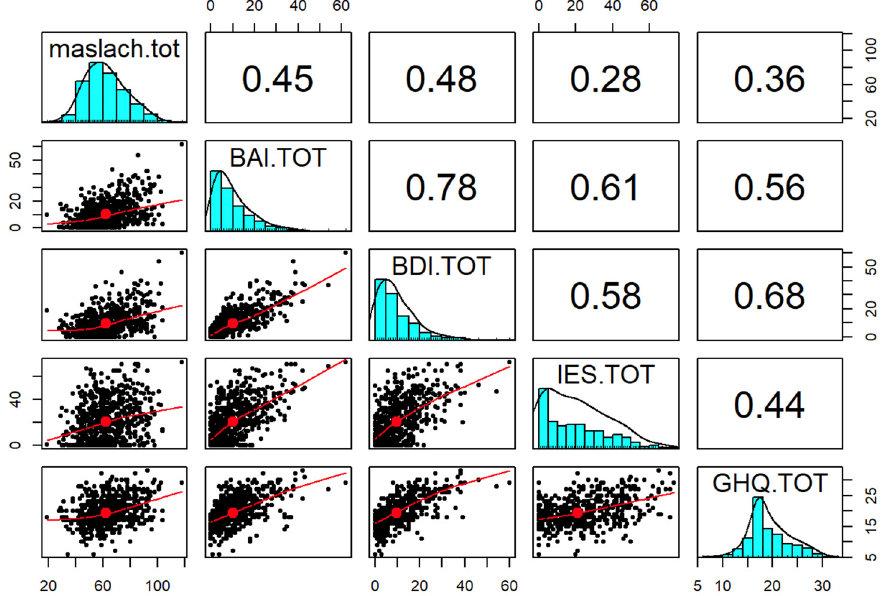
Figure 2. Observed Pearson correlations among Medical Personnel (MBI-HSS MP), Beck Depression Inventory (BDI-II), Beck Anxiety Inventory (BAI), Impact of Event Scale (IES) and General Health Questionnaire 12 Items (GHQ-12). Table 2. The model implied (fitted) correlation matrix among Medical Personnel (MBI-HSS MP), Beck Depression Inventory (BDI), Beck Anxiety Inventory (BAI), Impact of Event Scale (IES) and General Health Questionnaire (GHQ), Age categories, Gender, COVID-19 related symptoms, Changing of mansion due to the COVID-19 pandemic.